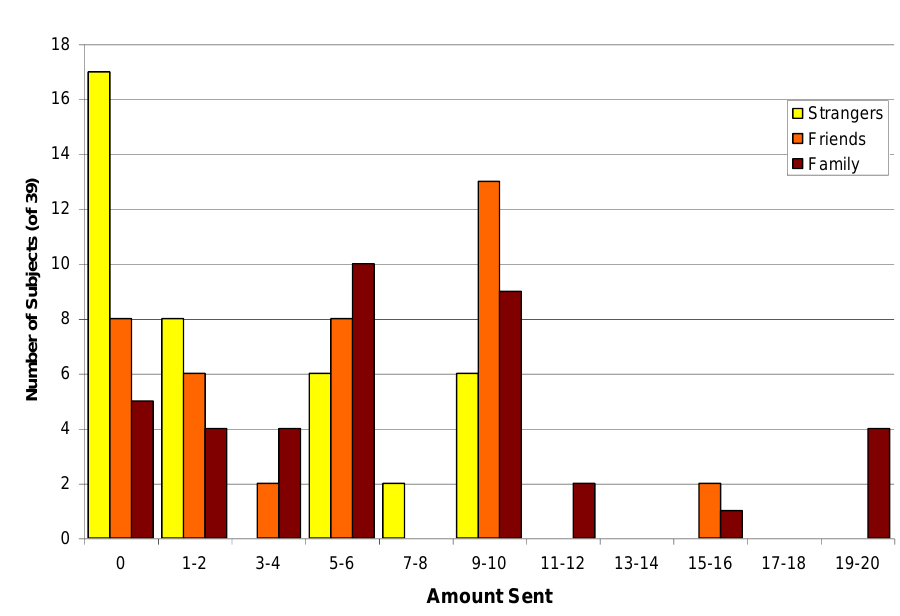
Figure A3. Donations in the comparative dictator game.